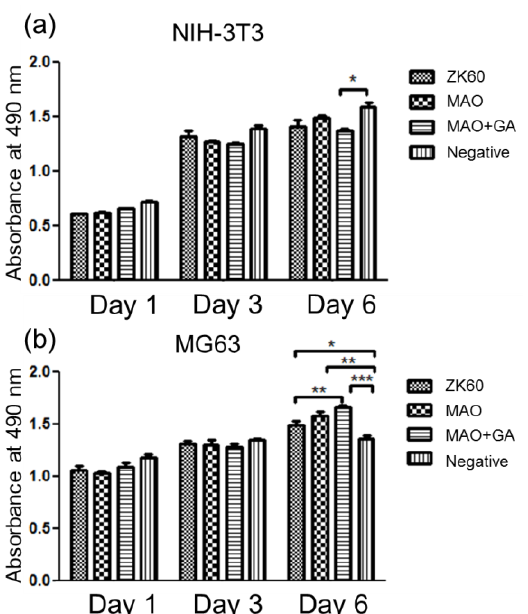
Figure 7. The cytocompatibility evaluation of ZK60, MAO, and MAO+GA with regard to ( a ) NIH-3T3 and ( b ) MG63. The data are presented as the mean ± SEM ( n = 5). * p < 0.05, ** p < 0.01, *** p < 0.001.